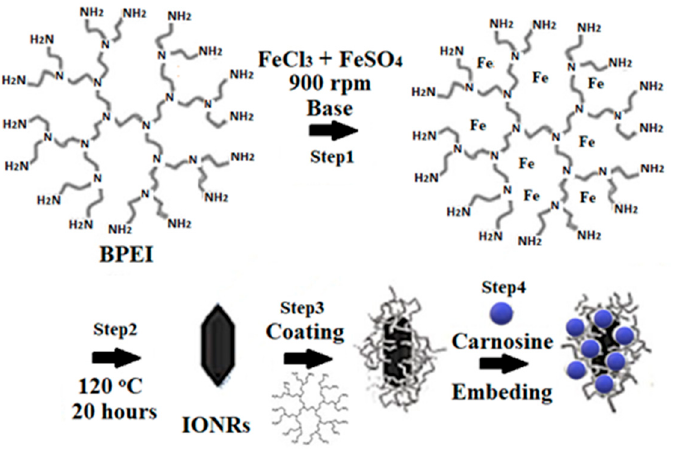
Scheme 1. Synthesis of nanotherapeutic carrier, loaded with carnosine.